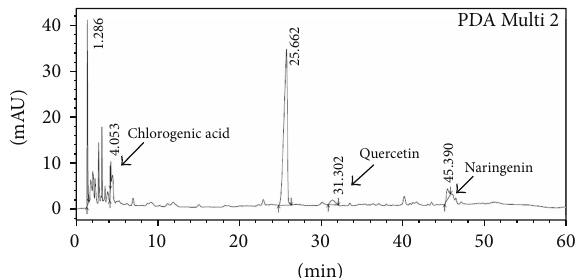
Figure 1: HPLC analysis of ethyl acetate fraction of Solanum nigrum Linn. The HPLC used a 4.6mm × 250 mm, 5 𝜇 m Merck C 18 reversed-phase column. The chromatogram was recorded at 295 nm (PDA Multi 2).